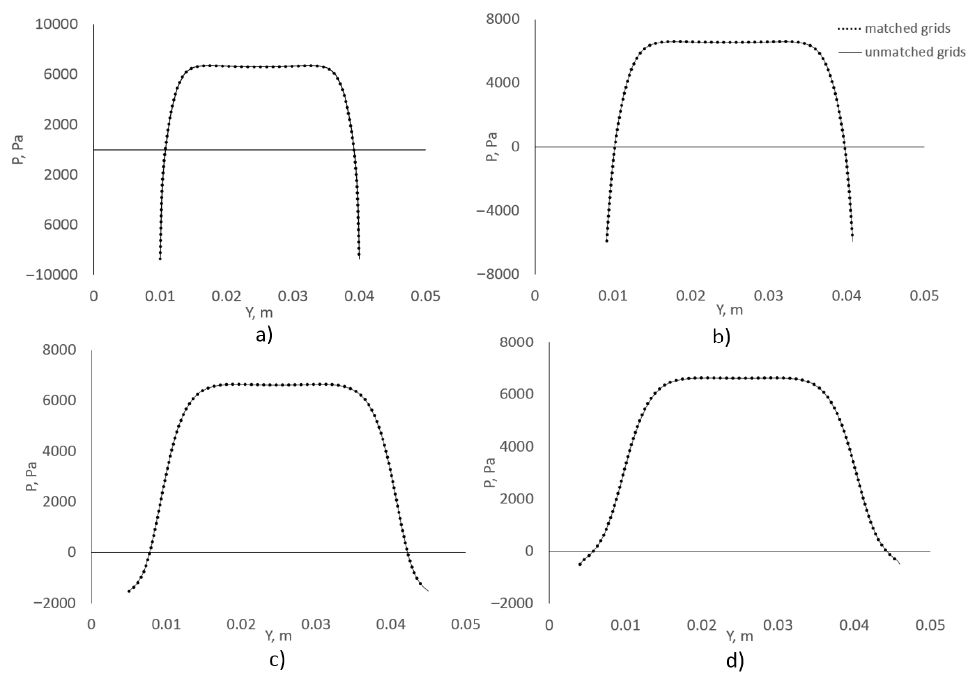
Figure 19. Profile of pressure at the control sections: ( a ) section A1, ( b ) section A2, ( c ) section A3, ( d ) section A4.